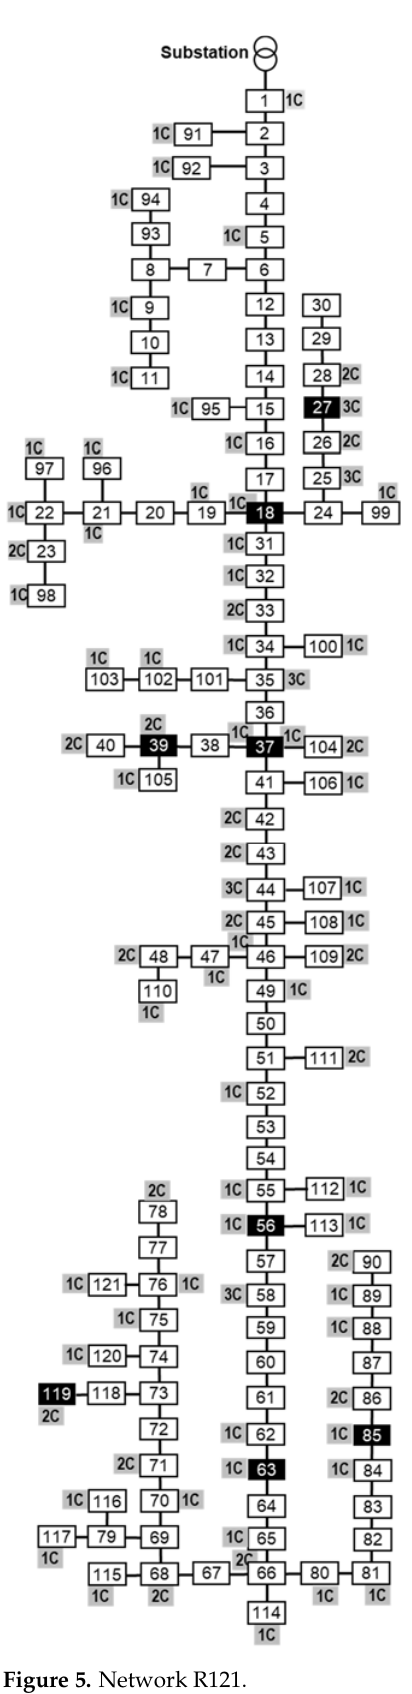
Figure 5. Network R121.